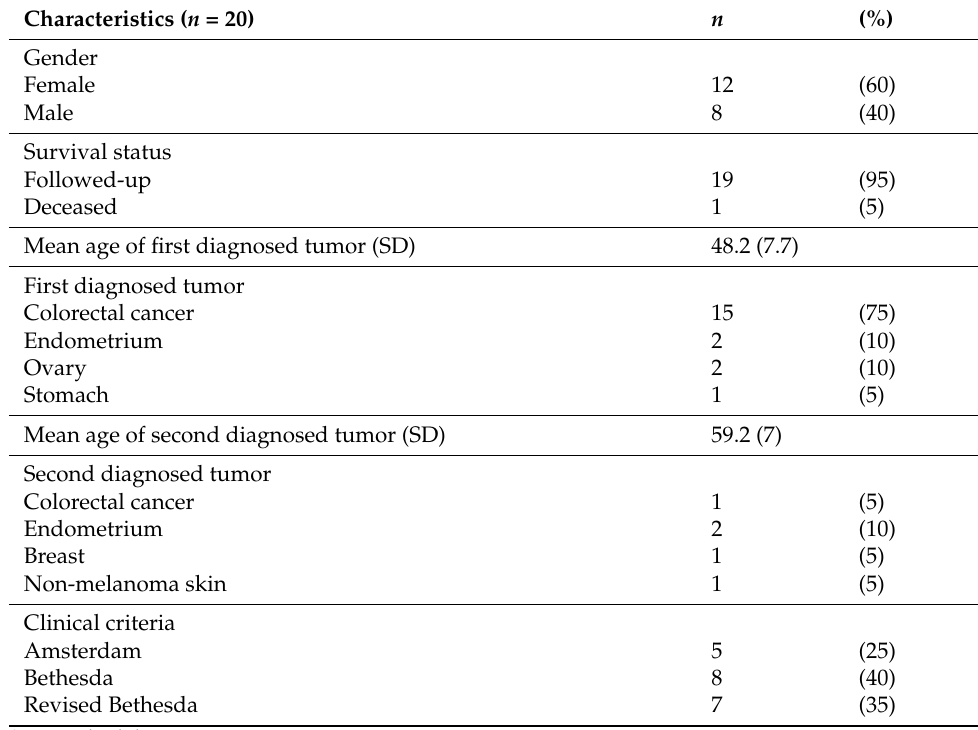
Table 1. Characteristics of patients with Lynch-like syndrome